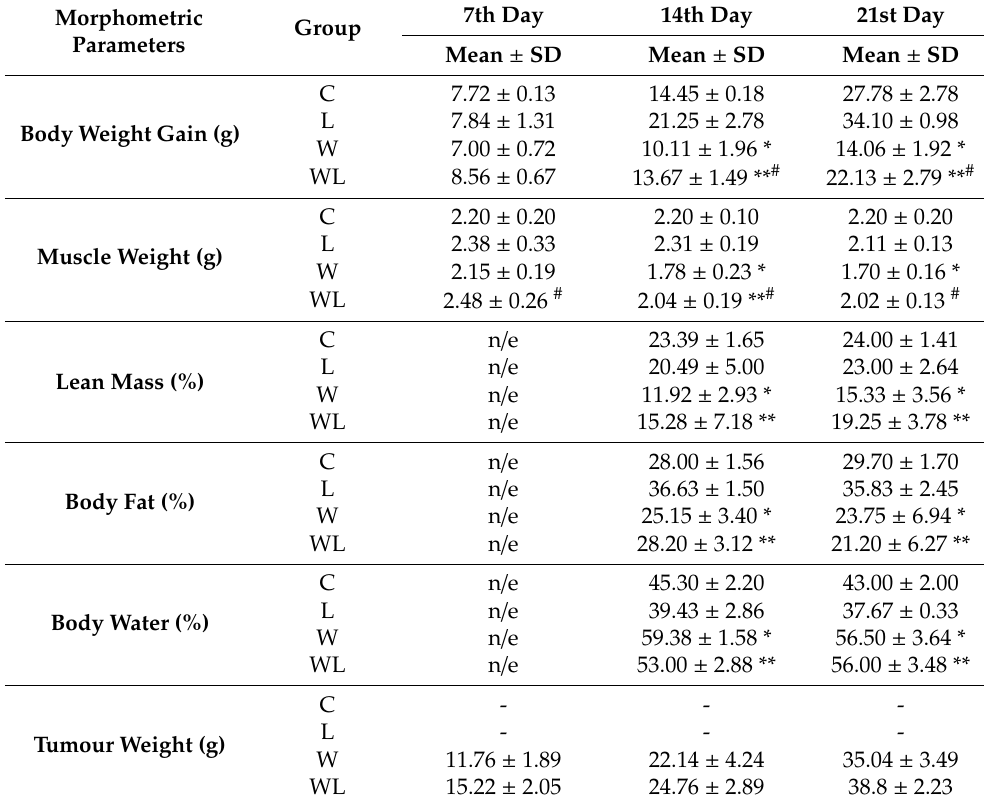
Table 1. Morphometric parameters of all experimental groups subjected or not to leucine-rich diet and tumour-bearing or control groups as a time-course